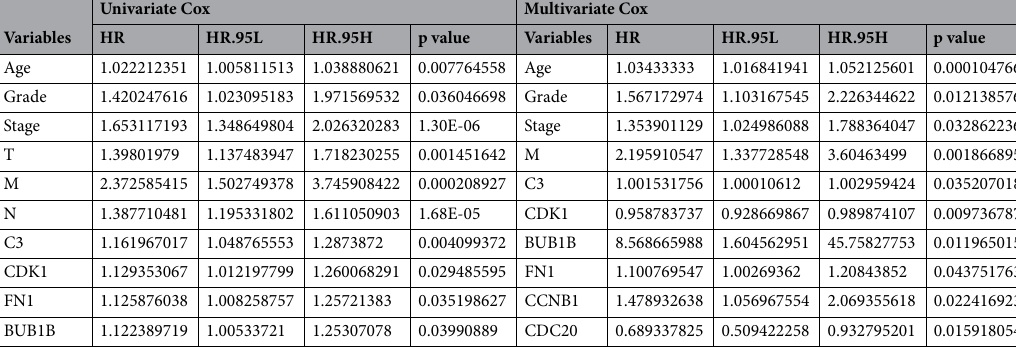
Table 2. Univariate and multivariate Cox analysis.